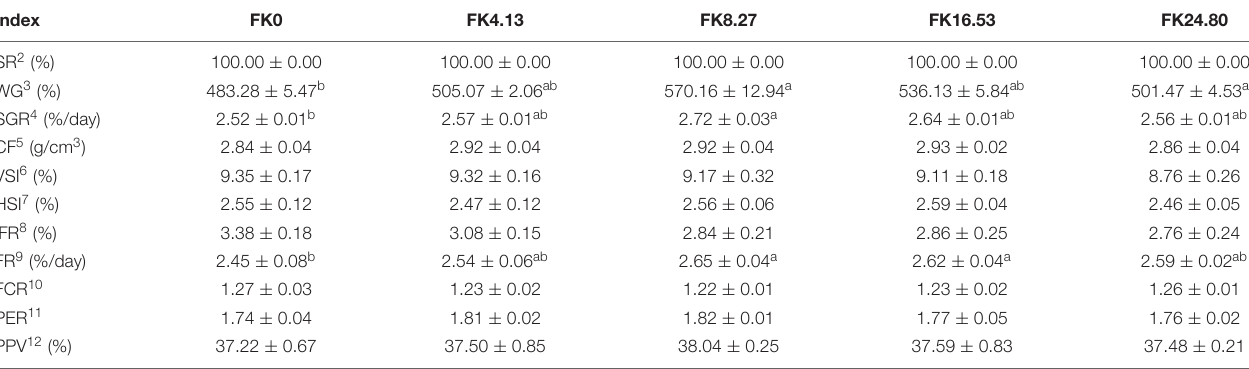
TABLE 3 | Growth performance and feed utilization of black sea bream fed with different diets 1